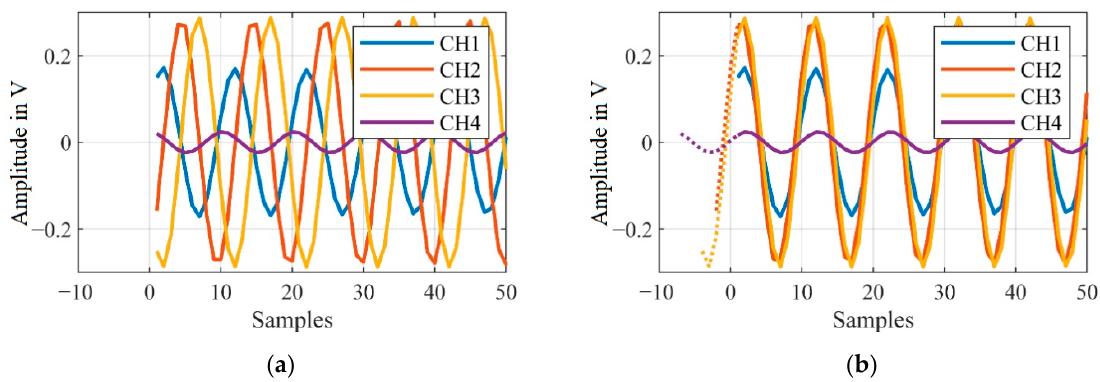
Figure 9. ( a ) Raw signals of the individual channels (CH1–CH4) without phase correction; ( b ) Raw signals with phase correction (samples with dotted lines are only shown for visualization of the shift).